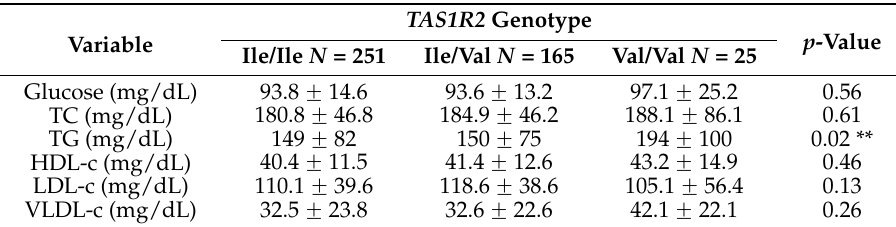
Table 4. Comparison of biochemical profile by TAS1R2 genotype.